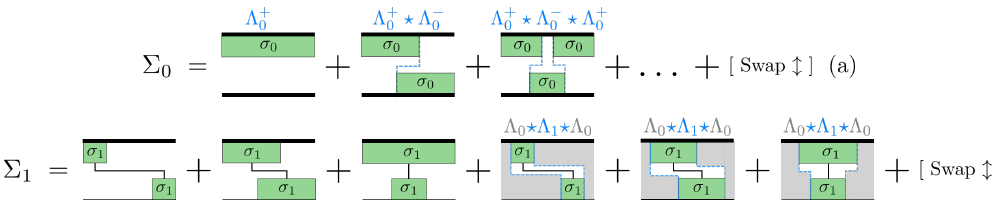
Figure 10: Conditional components Σ of the memory kernel Σ as explicit functional m (39) of the Keldysh- and Kraus operator memory-kernels σ . The bold black lines m indicate the full conditional propagator k with no external vertex. (a) For Σ , two- 0 0 [ σ † ] on branch irreducibility can only be ensured by alternating sequences of σ 0 0 opposite branches, cf. Eq. (38). (b) For the remaining Σ , a dressed expansion m can be set up in terms of the generators σ following the rules (i)-(v) in the main m text. This includes summation over all definite two-branch time-orderings of the self- ( τ , τ (cid:48) ) [ cf. Fig. 7(a) ] . An explicit construction of Σ energies σ is provided in App. F. m 2 The irreducible fragments Λ obtained in step (iii) can be complemented by the m (cid:48) ( t ) of Eq. (39a) to a four-time object, see rule generalization Λ , t (cid:48) + , t − , t + − 0